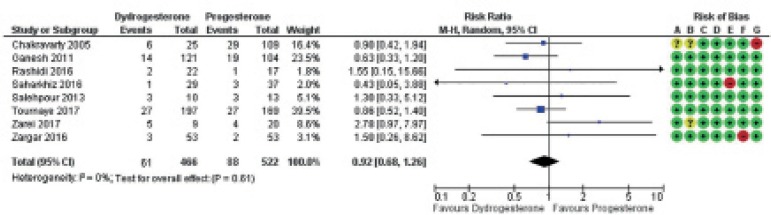
Forest plot for miscarriage. Risk of bias legend: A = Selection bias
(random sequence generation); B = Selection bias (allocation
concealment); C = Performance bias; D = Detection bias; E =
Attrition bias; F = Reporting bias; G = Other biases.